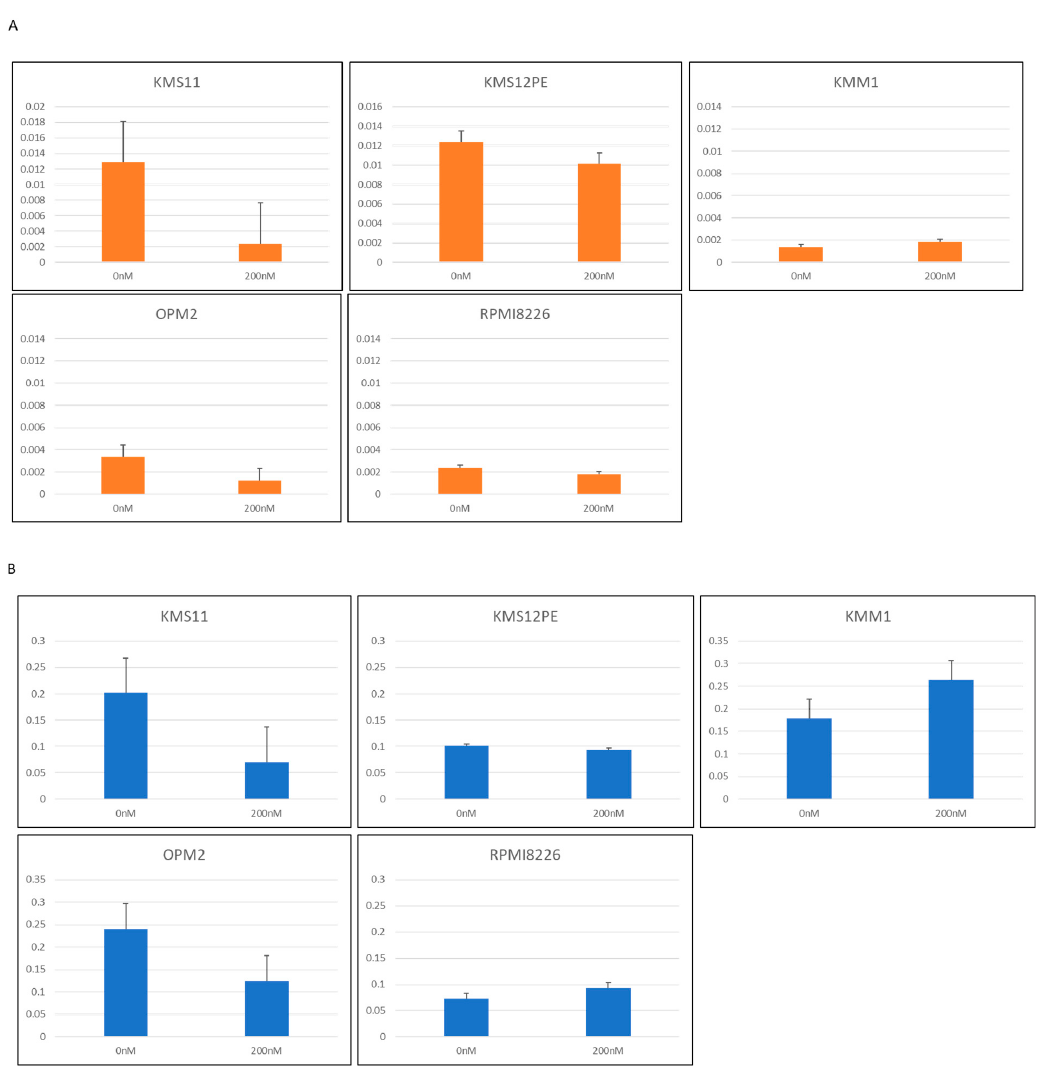
Figure 4. ( A ) PVT1 expression in MM cell lines treated with antisense oligonucleotide LNA™ long RNA GapmeR for PVT1 . ( B ) MYC expression in MM cell lines treated with antisense nucleotide LNA™ long RNA GapmeR for PVT1 .